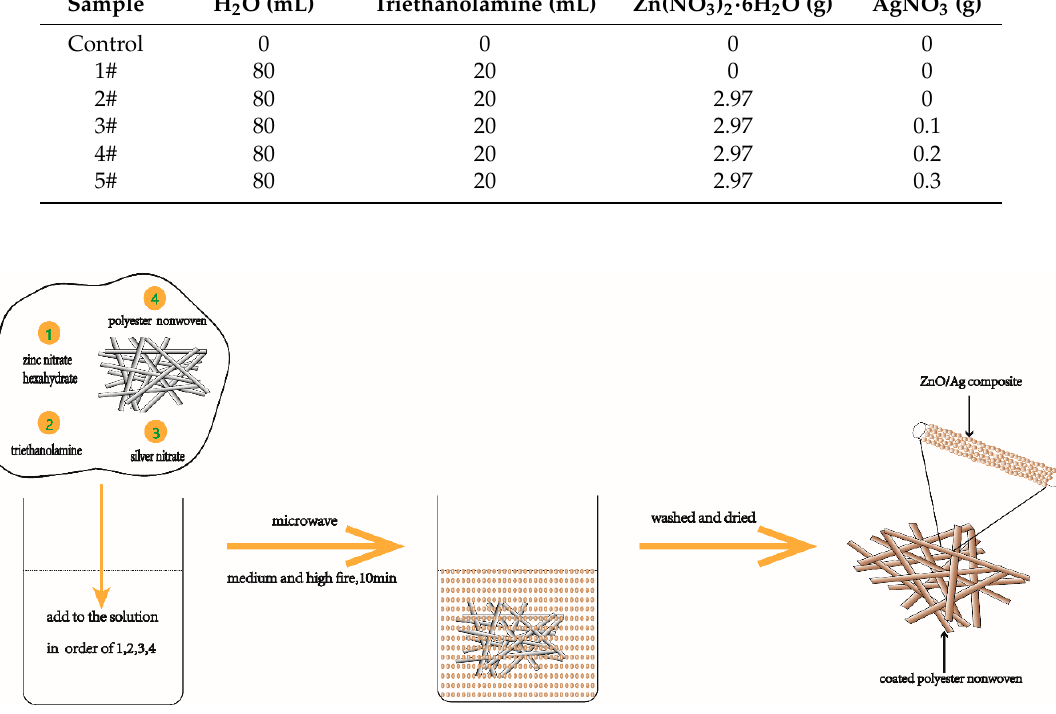
Figure 1. Schematic of rapid ZnO/Ag composite functionalization of polyester nonwoven by microwave-assisted.